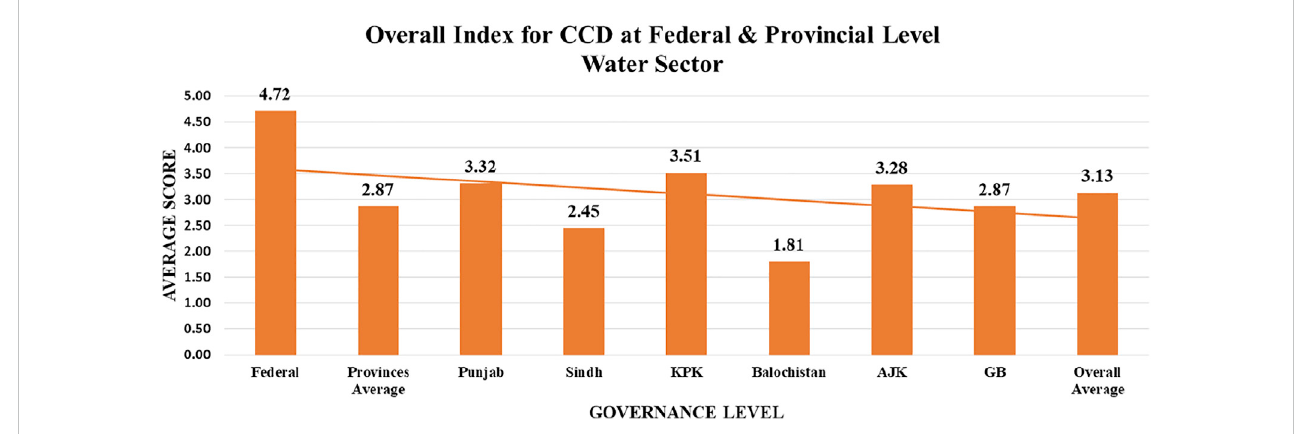
FIGURE 6 National and subnational state of water sector governance.